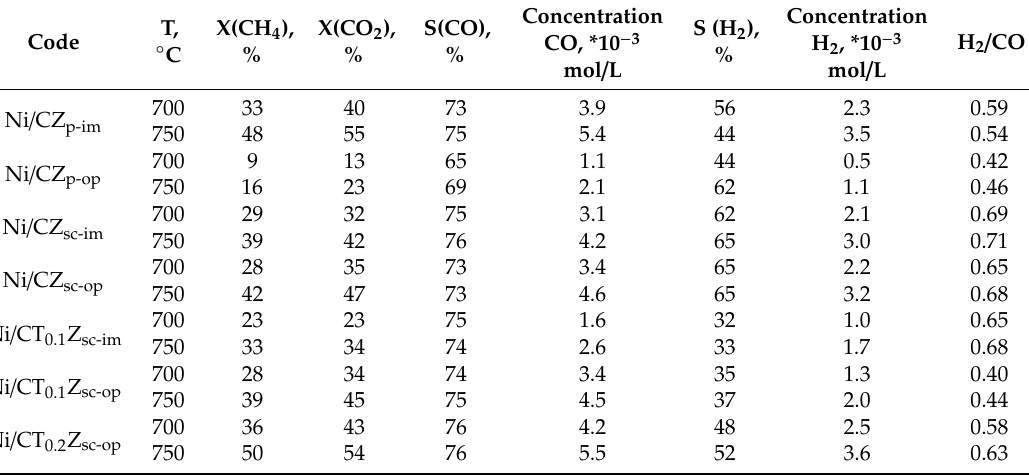
Table 3. Conversion of CH 4 (X) and CO 2 , selectivity (S), concentration of H 2 and CO and H 2 /